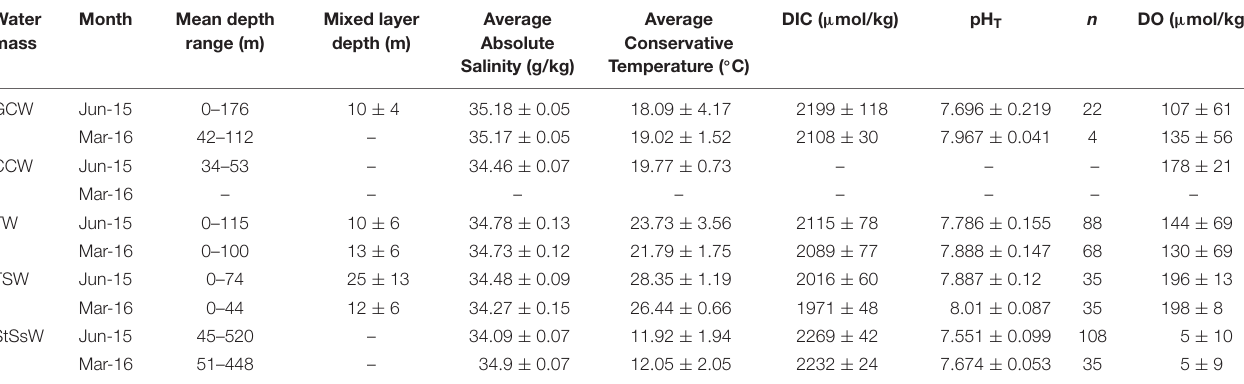
FIGURE 2 | Conservative temperature ( (cid:50) , ◦ C) and absolute salinity (S A , g/kg) diagram. Top figures, June 2015; bottom figures, March 2016. In color: (A,B) latitude in ◦ N, (C,D) seasonal climatology was taken from World Ocean Atlas 2009, (E,F) dissolved inorganic carbon (DIC). The acronyms utilized are Gulf of California Water (GCW), California Current Water (CCW), Transitional Water (TW), Tropical Surface Water (TSW), Subtropical Subsuperficial Water (StSsW), and Pacific Intermediate Water (PIW). Water masses were classified according to Portela et al. (2016). TABLE 2 | Physical and chemical characteristics of the water masses in the Tropical Pacific in front of